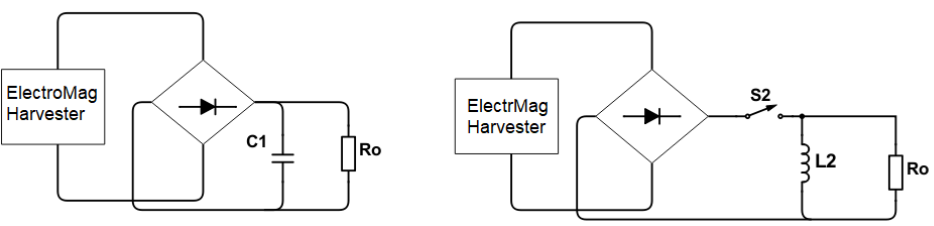
Figure 2. Rectifier for energy harvester. On the left — linear rectifier. On the right — nonlinear recti- fier.